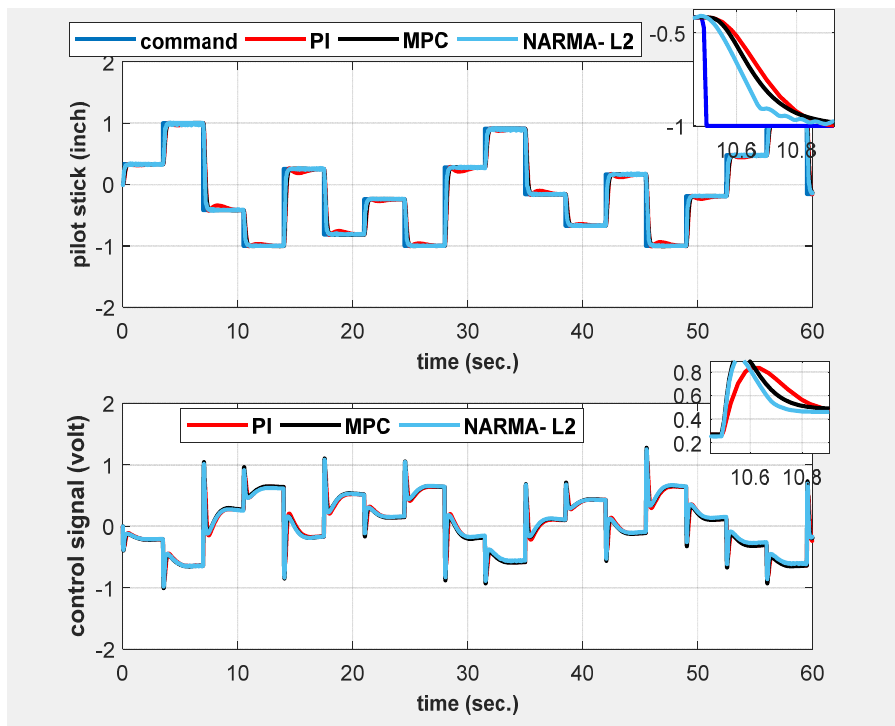
Figure 15. Pilot stick multistep response without corresponding error.